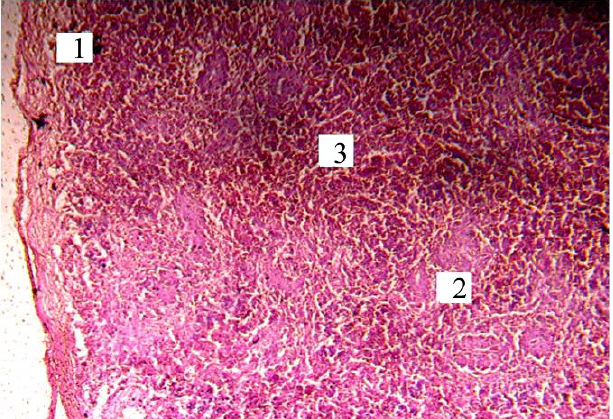
Fig. 2. Microscopic structure of the spleen of a 15-day- old vaccinated chicken: 1 – capsule; 2 – diffuse lymphoid tissue; 3 – red pulp. Hematoxylin and eosin. x 100. The histoarchitectonics of the spleen of 25-day-old chickens of the experimental and control groups were formed by white and red pulps and connective tissue stroma, which is very weakly developed. There are no trabeculae; only a small amount of connective tissue is found along the course of the vessels. According to histological studies, the WP of the organ of 25-day-old chickens was represented by diffuse lymphoid tissue, periarterial lymphoid sheaths, and the presence of lymphoid nodules (LN) (Fig. 3). For this, the number of LN was 2.33 ± 0.42 pcs. In the 25-day-old chick- ens of the control group, instead of formed LNs, we noted only different accumulations of lymphoid tissue that did not have a clear